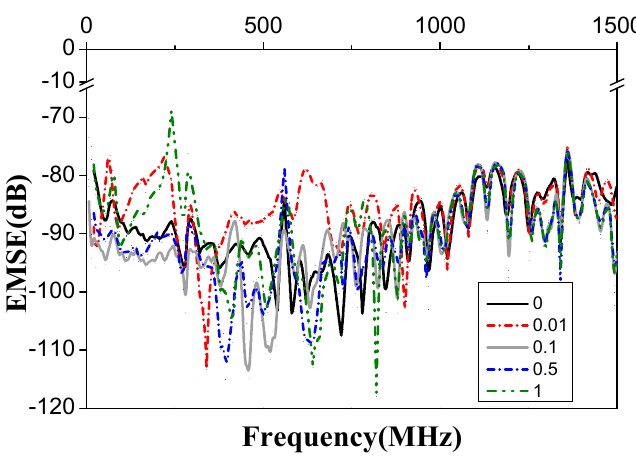
Figure 7. Electromagnetic interference shielding effectiveness (EMSE) curves of the PVA/GR nanofiber films as related to the content of graphene (0.01, 0.1, 0.5, and 1 wt %). Both the experimental and control groups consist of an aluminum foil.